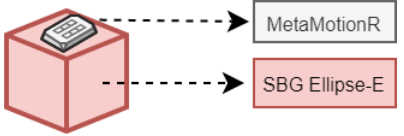
Figure 3. SBG and MMR measurement configuration.